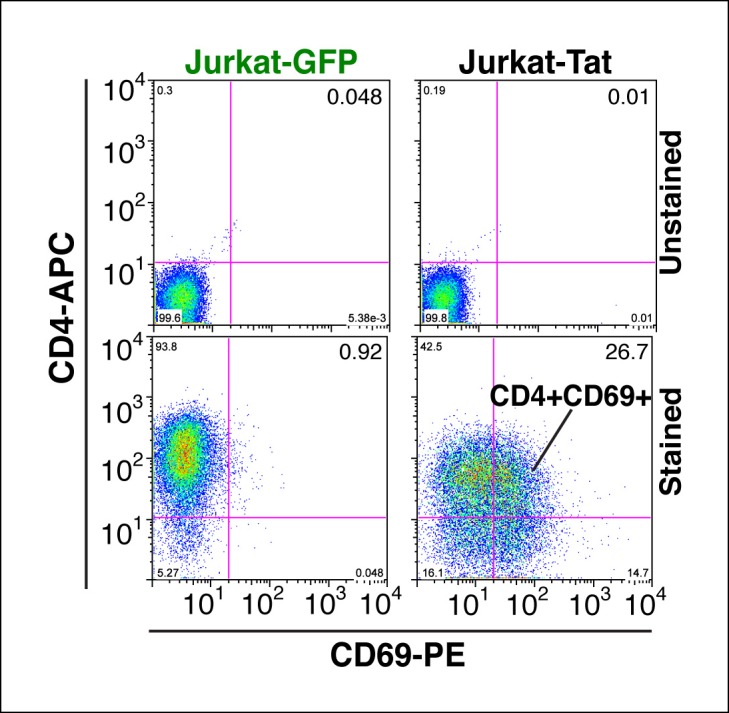
Tat-induced transcriptome changes are also observed at the protein level.Flow cytometry analysis of Jurkat-GFP and -Tat cell lines induced with doxycycline for 24 hr and stained with CD4-APC and CD69-PE antibodies or unstained (negative control) to monitor levels of CD4 and CD69 proteins expressed at the cell surface. Note the increase in the CD69+ population in the presence of Tat. GFP, green fluorescent protein.